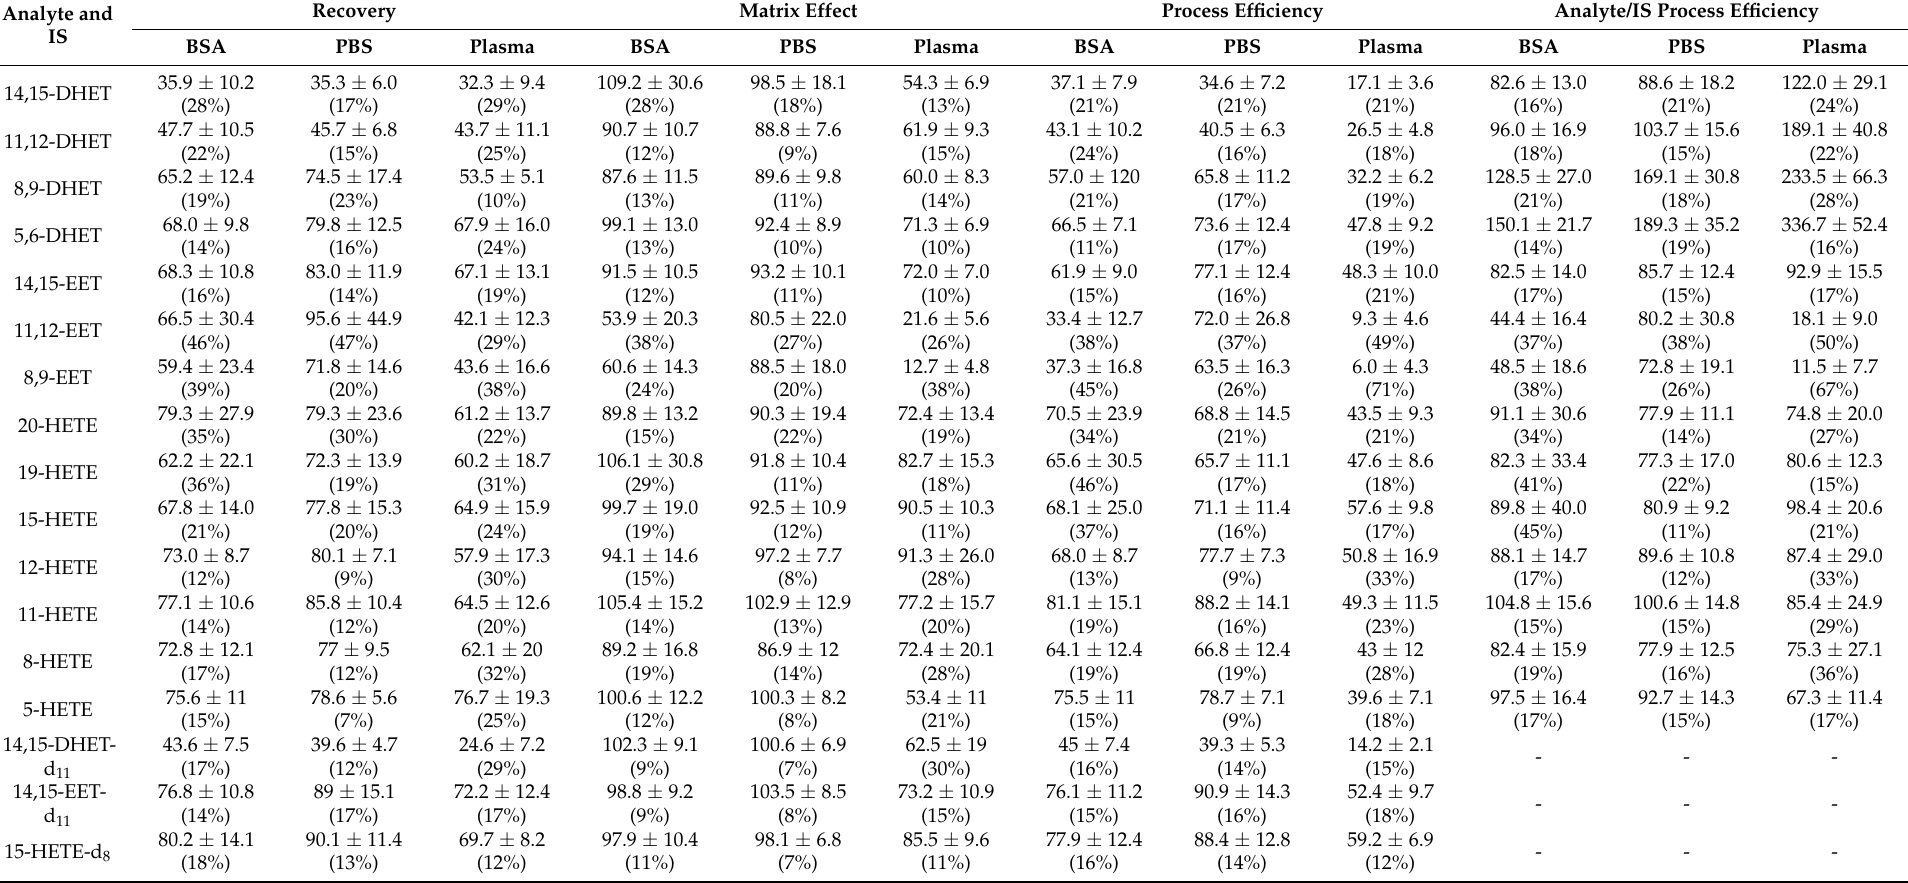
Table 1. Recovery, matrix effect and process efficiency values for DHETs, EETs, and HETEs from BSA, PBS, and